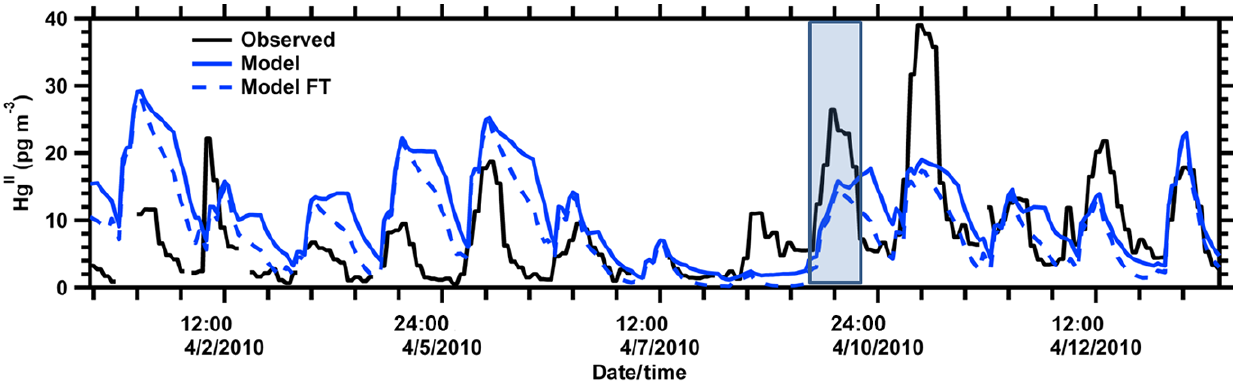
Figure 9. Observed (black solid trace) and simulated (blue traces) concentrations of oxidized mercury (Hg II = GOM + PBM) during April 2010 (9 April highlighted). Model results from GEOS-Chem (solid) include a sensitivity test, labeled FT (dashed trace), in which North American anthropogenic emissions are zero and no GEM oxidation occurs in the lower troposphere ( > 700hPa); therefore all Hg II in the “FT” model is derived from oxidation of in the free troposphere or long-range